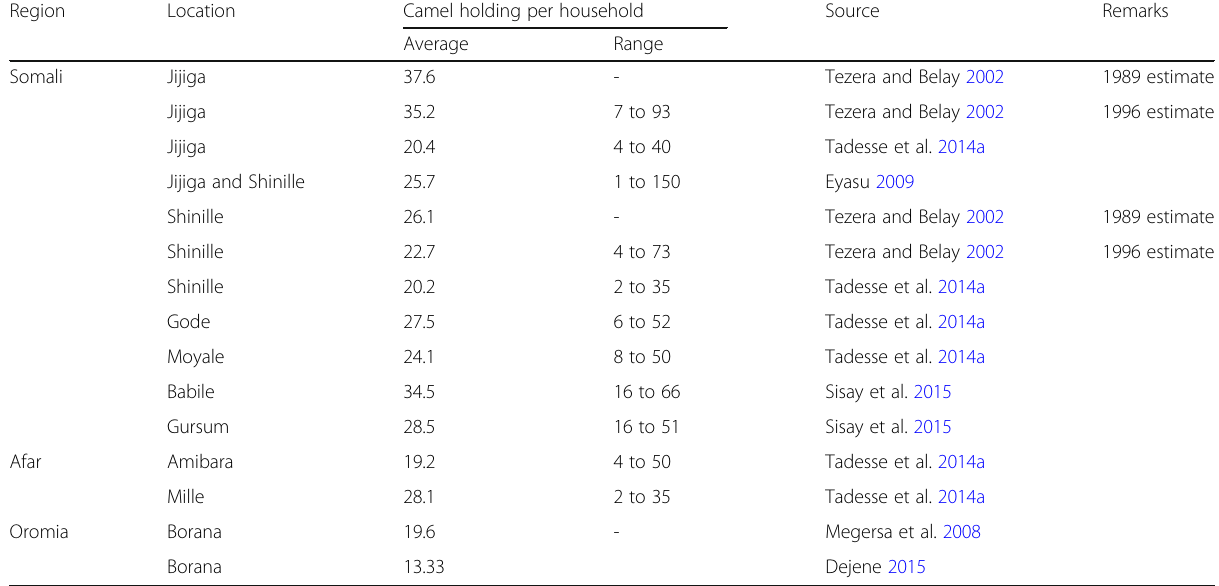
Table 2 Average camel holding per household in major camel-rearing areas Region Location Camel holding per household